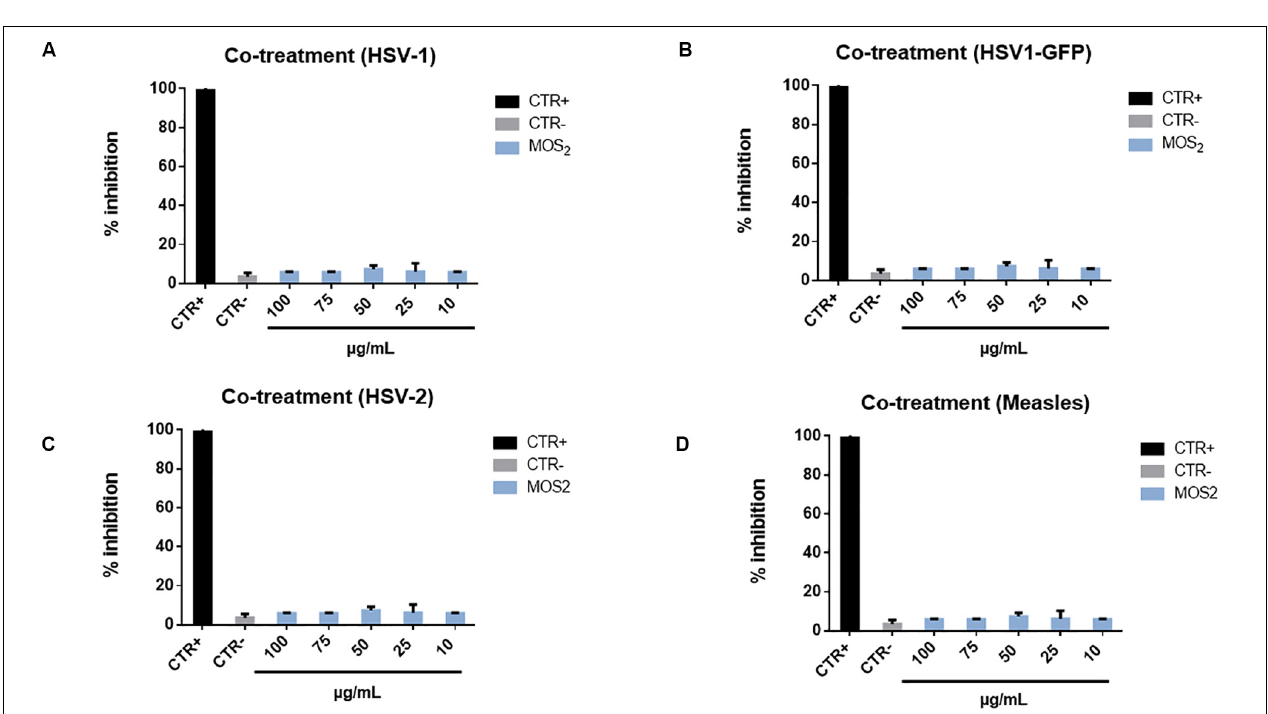
FIGURE 7 | Virus pre- treatment with MoS 2 and GO NSs. HSV-1 infectivity inhibition with MoS 2 (A) and GO NSs (B) , of two different types GO(1) and GO(2), having different lateral size and thickness. Not infected and not treated cells represented the positive control (CTR+), meanwhile infected cells were the negative control (CTR–). The data statistical error is the standard deviation of three independent experiments. P -value is less than 0.05.